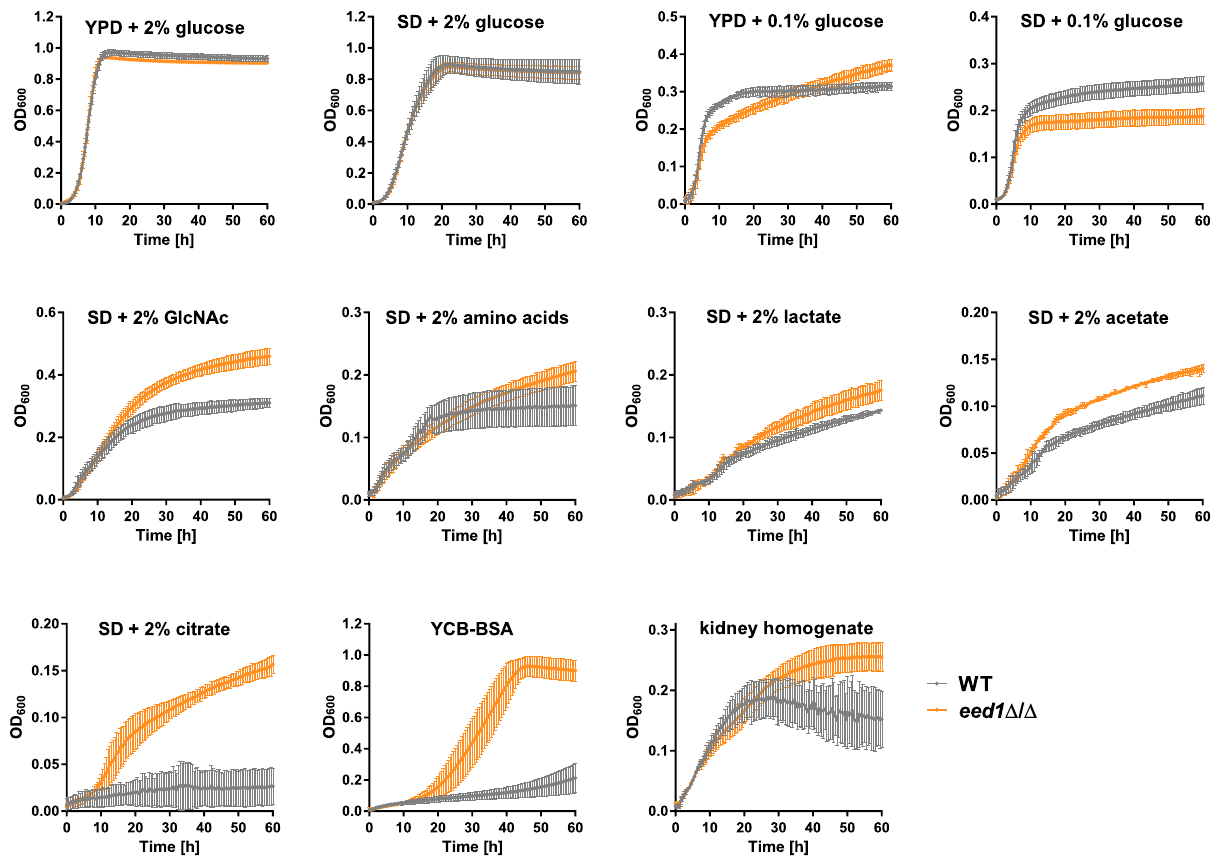
Fig. 6 eed1 Δ / Δ yeast have a growth advantage on physiologically relevant carbon sources and kidney homogenates and furthermore show enhanced proteolytic activity. Growth curves of C. albicans in YPD with 2 or 0.1% glucose or SD medium with different concentrations of sugars or alternative carbon sources as indicated in the graphs. YCB-BSA contained 0.5% of BSA as sole nitrogen source, pH was adjusted to 4.0. For kidney homogenates, kidneys of uninfected mice were removed aseptically, homogenized and diluted to 25 mg/ml in DPBS. Growth was recorded by measuring the optical density at 600 nm in a microplate reader at 37 °C. Measurements were performed in 30 min intervals over a course of 60 h. Graphs show the mean ± SD of three to fi ve independent biological replicates. Source data are provided as a Source Data fi